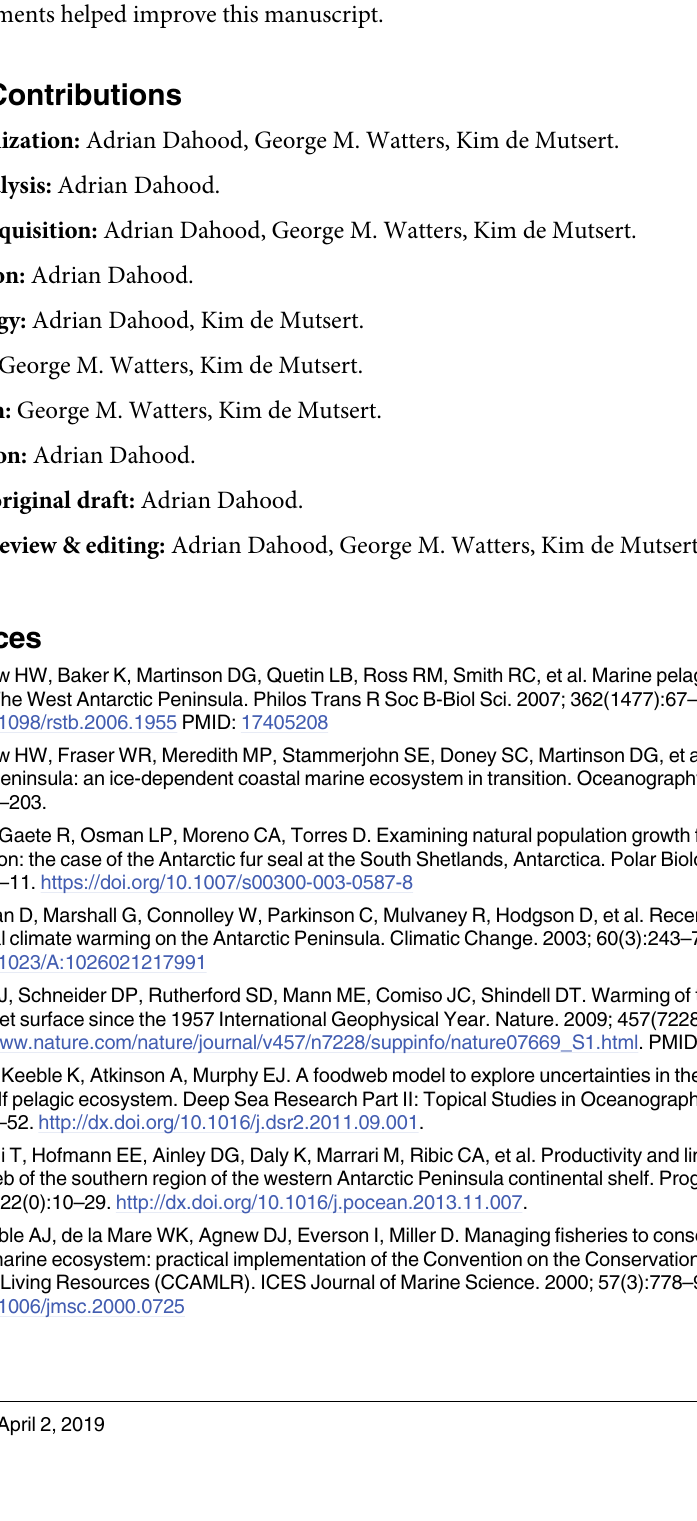
S8 File. Mixed trophic impact analysis. Black indicates a negative impact, white indicates a positive impact; size of the circle indicates strength of the impact.